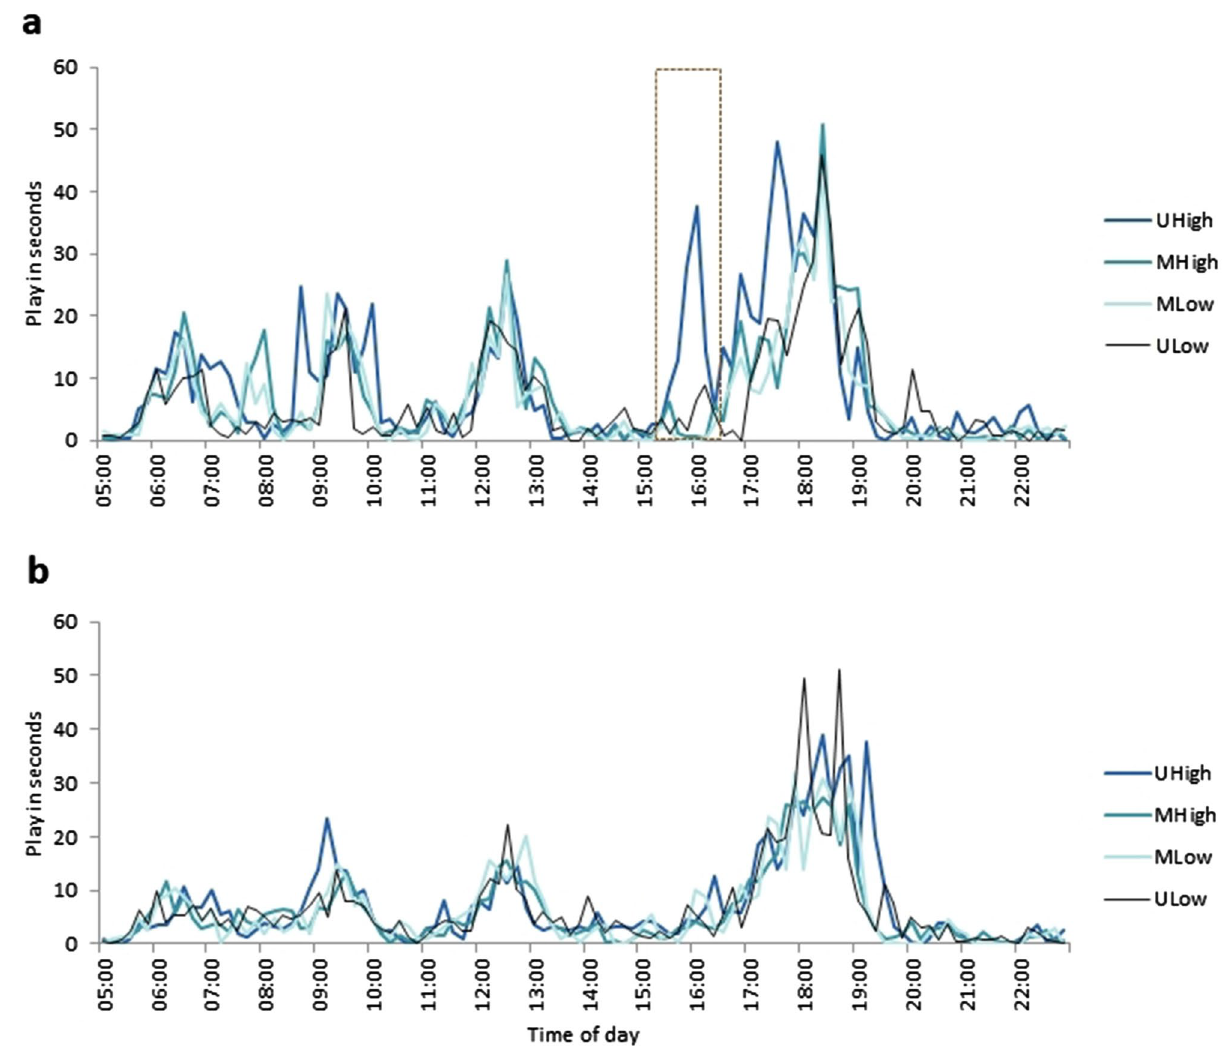
Figure 4. Distribution of locomotor play across the day for four week ( a ) and eight week ( b ) old calves. Data were calculated as seconds of locomotor play per ten minutes of